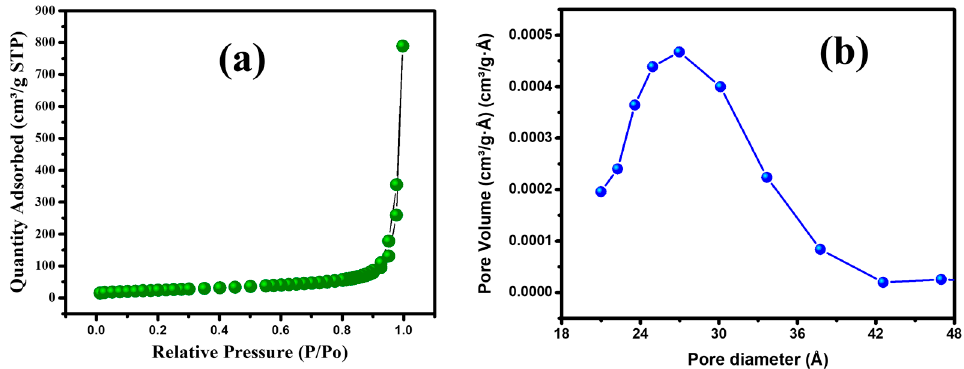
Figure 1. ( a ) Adsorption isotherm and ( b ) pore size distribution of MGCN sorbent. The Raman spectrum ranging from 0–2000 cm − 1 is shown in Figure 2a. The peak below 400 cm − 1 belongs to MgO [37]. The inset in Figure 2a presents three main peaks located at ∼ 1237, 1381, and 1516 cm − 1 belonging to the C–N, and C=N stretching